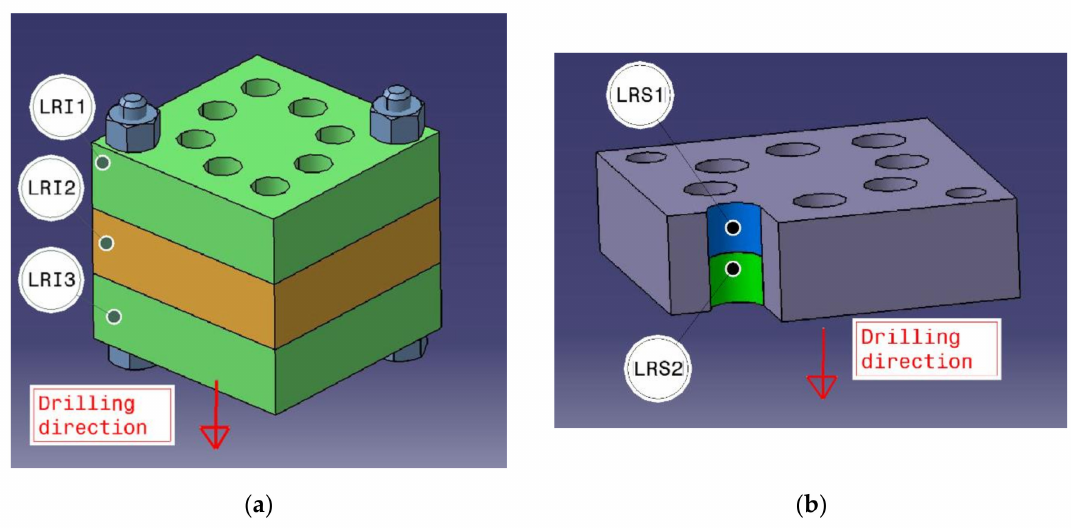
Figure 1. Detail of the position of the roughness measurements inside each Mg-Al-Mg specimen; ( a ) Location Regarding Insert, LRI ; ( b ) Location Regarding Specimen, LRS